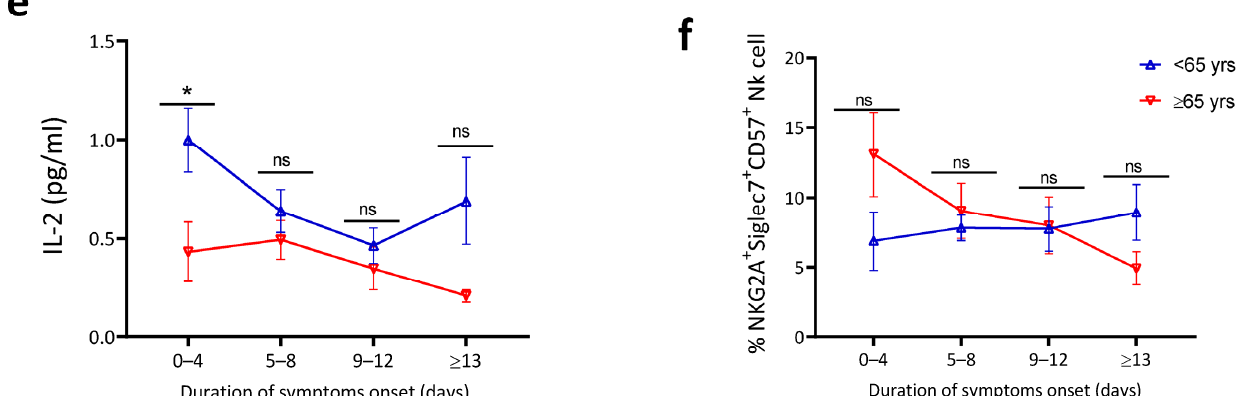
Figure 4. Increased natural killer cell activation and IL-2 levels in younger patients. Natural killer cell response and cytokine level analysis from PBMC and serum, respectively. ( a ) Percentage of CD56 bright NK cells. ( b ) Percentage of CD56 dim NK cells. Mean fluorescence intensity (MFI) of ( c ) CD11b of CD56 bright NK cells, ( d ) CD122 of CD56 dim NK cells, ( e ) serum IL-2 level, and ( f ) percentage of NKG2a + Siglec7 + NK cells ( n = 83). The data are shown as mean ± SEM. The statistical comparison of below 65 years (<65 years) vs. above 65 years ( ≥ 65 years) was performed using Student’s t -test (ns: not significant, * p < 0.05).